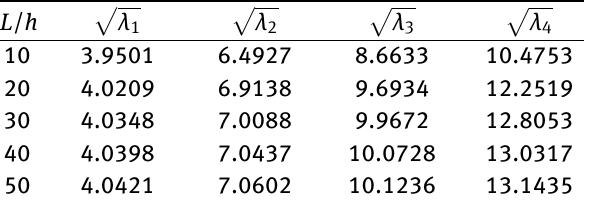
Table 21: Frequency parameter length-to-height